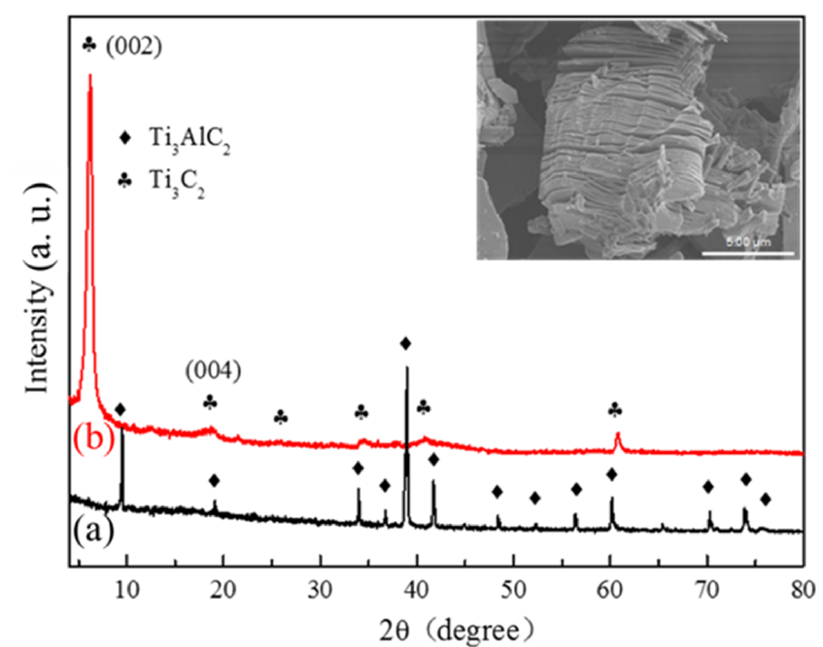
Figure 1. XRD patterns of ( a ) Ti 3 AlC 2 and ( b ) as-prepared Ti 3 C 2 . The insert is the SEM image of Ti 3 C 2 . Five composites of NaMgH 3 -x wt.% Ti 3 C 2 (x = 0, 3, 5, 7, and 9) were formed/synthe-